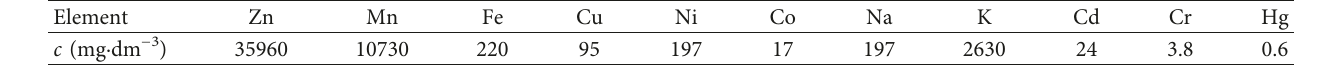
Table 1: The content of elements in the solution after acid leaching of battery waste. Element